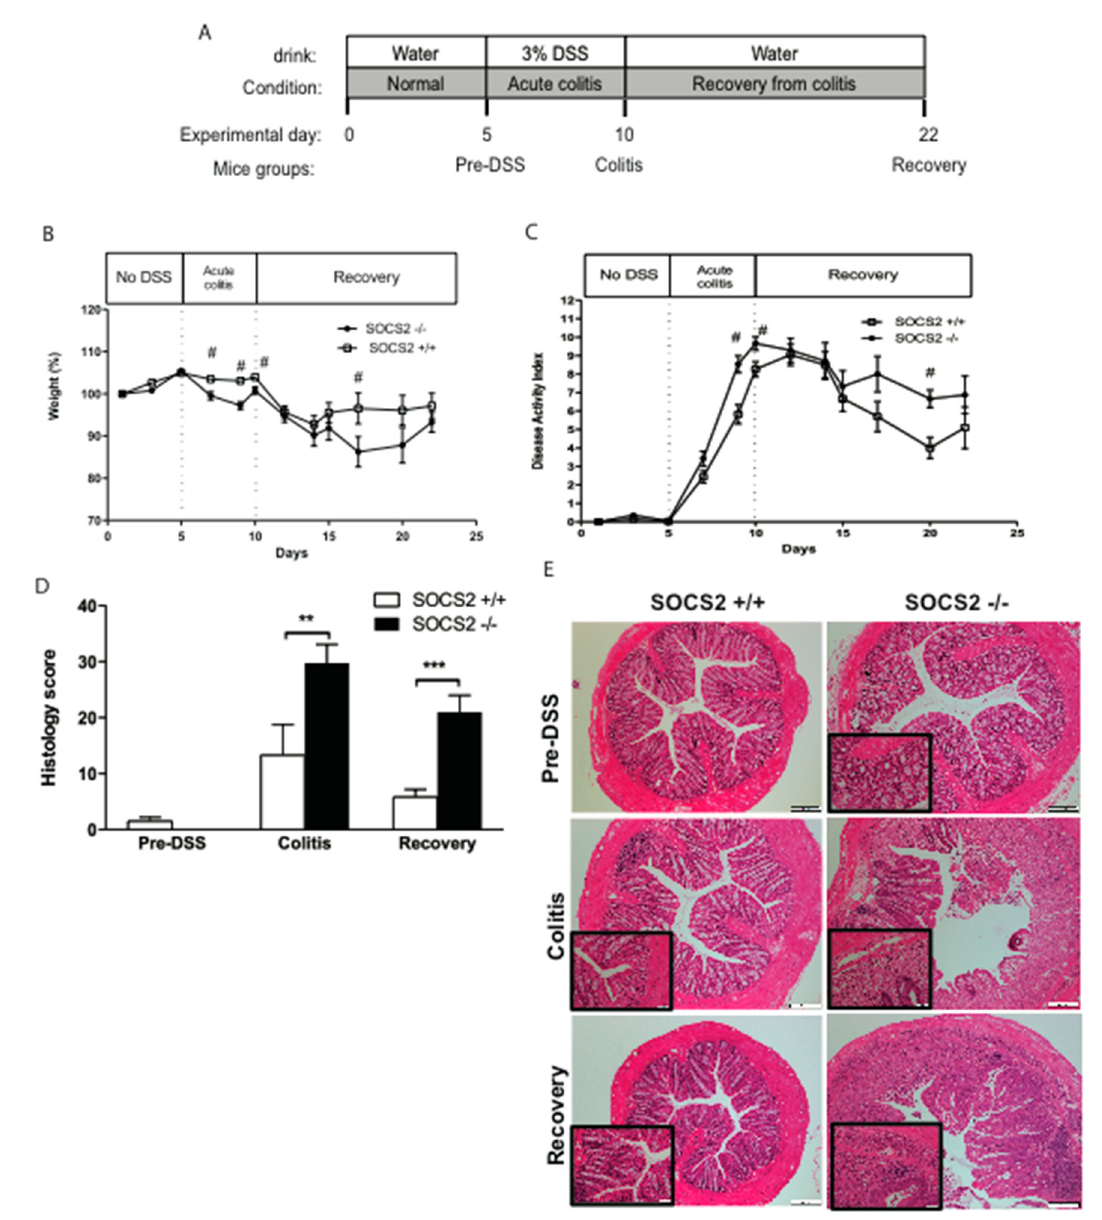
Figure 1. SOCS2 deletion aggravates colitis severity in mice. ( A ) Experimental design of dextran sodium sulphate (DSS)-induced colitis. Both wild-type (SOCS2 +/+ ) and SOCS2-knockout (SOCS2 − / − ) mice were sacrificed at three time points. Prior colitis (Pre-DSS), after DSS-induced colitis and at recovery 12 days after abstaining DSS from drinking water. Percentage of body weight changes ( B ), macroscopic colitis severity index ( C ) and histological colitis score ( D ) in SOCS2 +/+ and SOCS2 − / − mice at three time points of the model. ( E ) Hematoxylin and eosin staining of the distal colon from mice at the three time points of the model taken at 10x magnification. Magnified sections (X40) are shown in the bottom left corner. Details of the macroscopic and histological assessments are described in the Methods section. Student’s t -test p -values: # < 0.05, ** < 0.01, *** < 0.001; n = 10 mice per group.